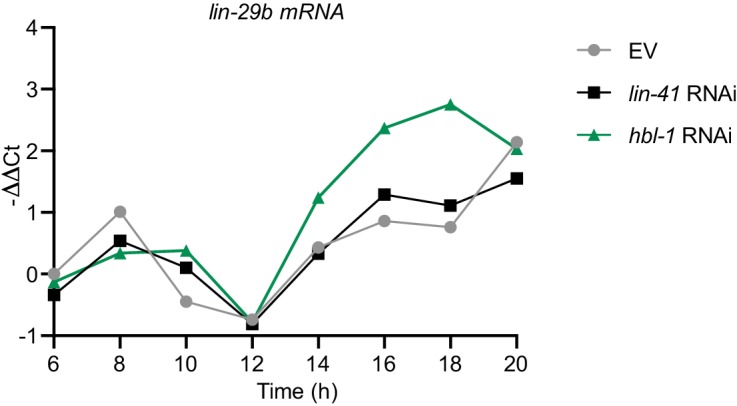
mRNA levels of lin-29b in worms grown on lin-41 and hbl-1 RNAi over time.RT-qPCR analysis to measure the -∆∆Ct of lin-29b mRNA levels (normalized by act-1 mRNA levels) over time. Wild-type animals exposed to lin-41 and hbl-1 RNAi compared to mock RNAi.